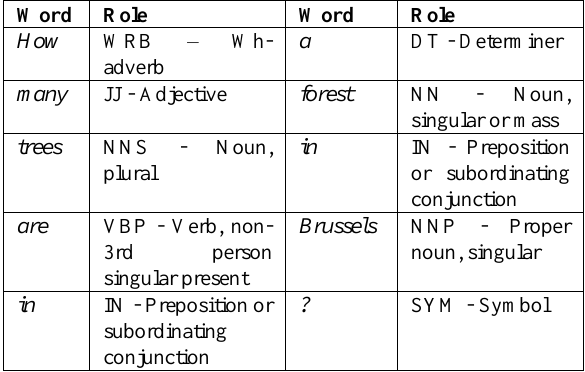
Table 1. Example of PoS Tagging